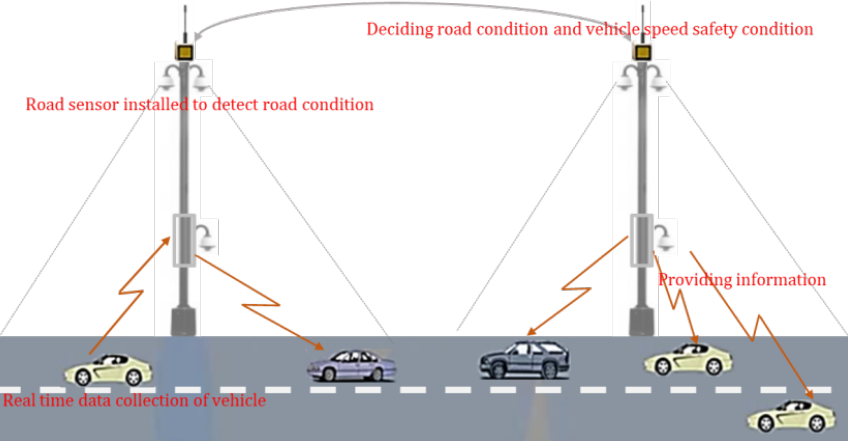
Figure 1. Intelligent road sensor structure.